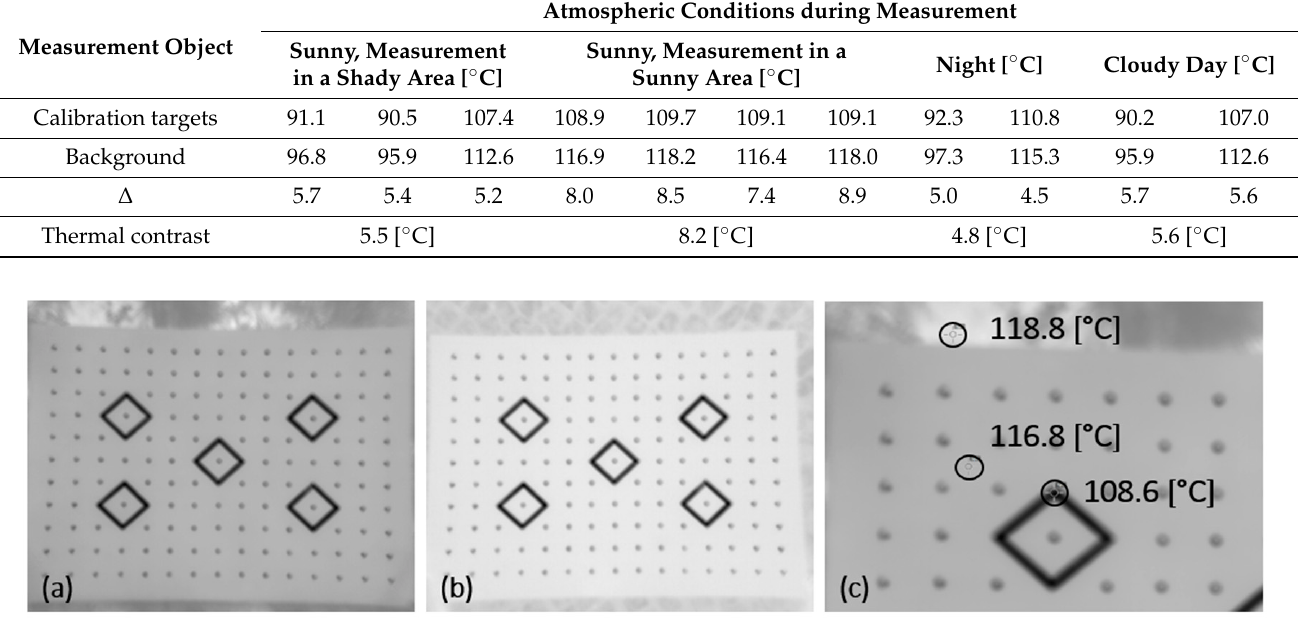
Figure 15. Visual analysis of the sharpness of thermograms: ( a ) daytime, shady area; ( b ) daytime, sunny area; ( c ) value measurement on the thermogram.